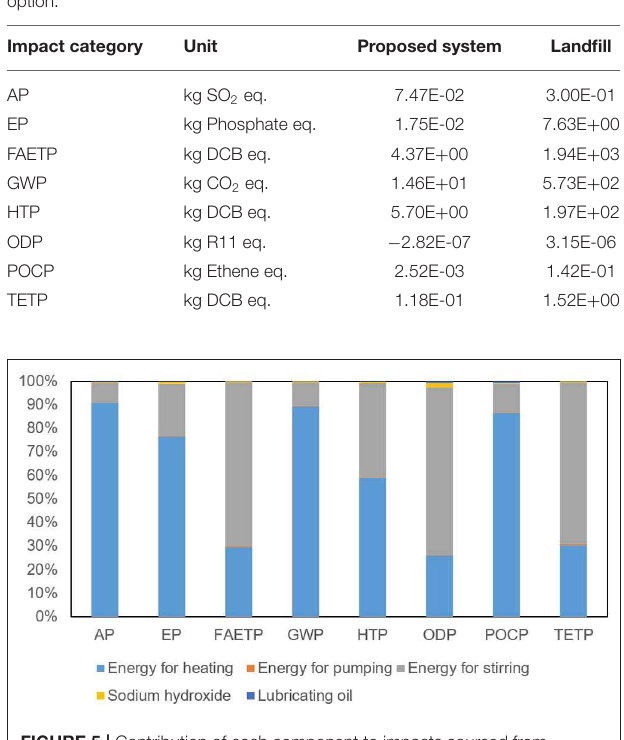
FIGURE 5 | Contribution of each component to impacts sourced from